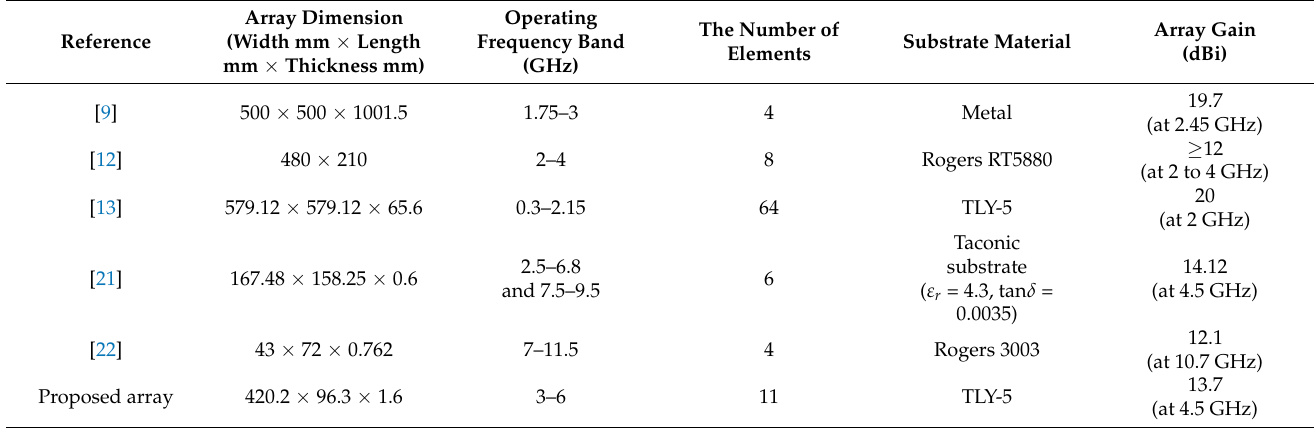
Figure 10. Array beam steering gains at 4 GHz and 5 GHz: ( a ) θ 0 of 0 ◦ at 4 GHz; ( b ) θ 0 of 15 ◦ at 4 GHz; ( c ) θ 0 of 0 ◦ at 5 GHz; ( d ) θ 0 of 15 ◦ at 5 GHz. Table 3. Comparison of the wideband array.